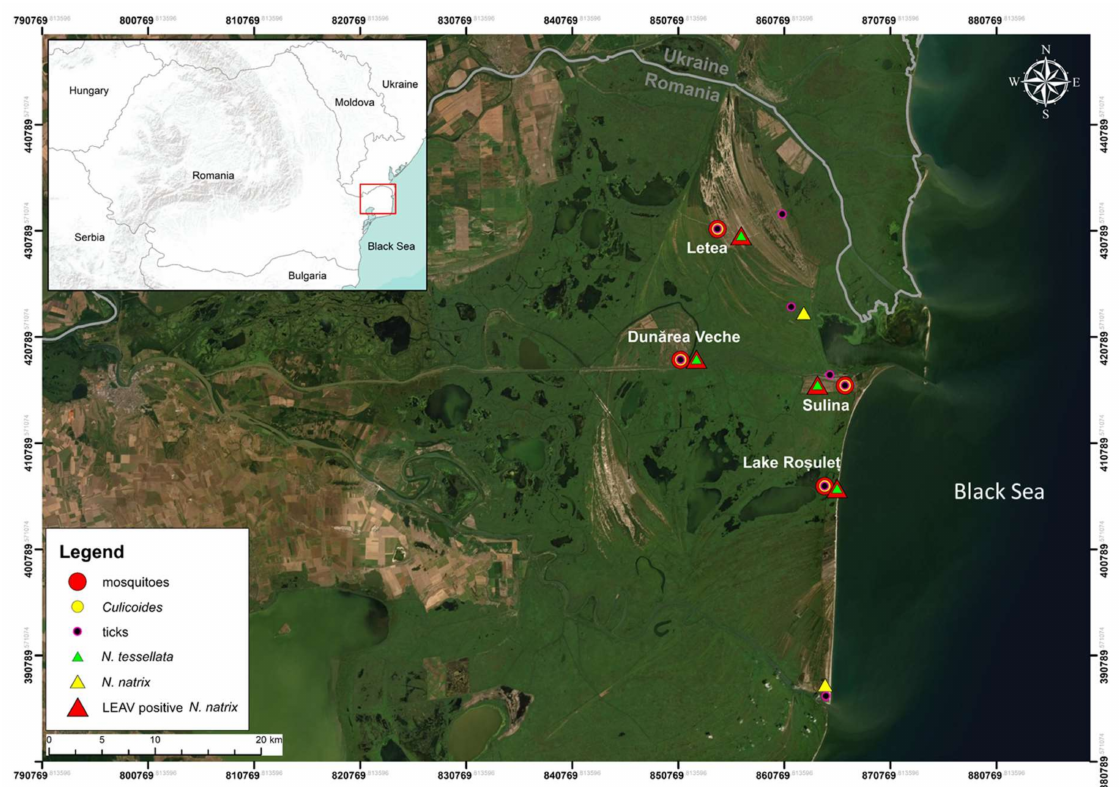
Figure 1. Satellite image of the study area (source: Esri) with sampling sites of grass and dice snakes and arthropods in Danube Delta Biosphere Reserve (Romania) during the study period 2014–2017. The various arthropod vectors were collected during 2014–2016 (mosquitoes), 2014–2017 (ticks) and 2017 ( Culicoides